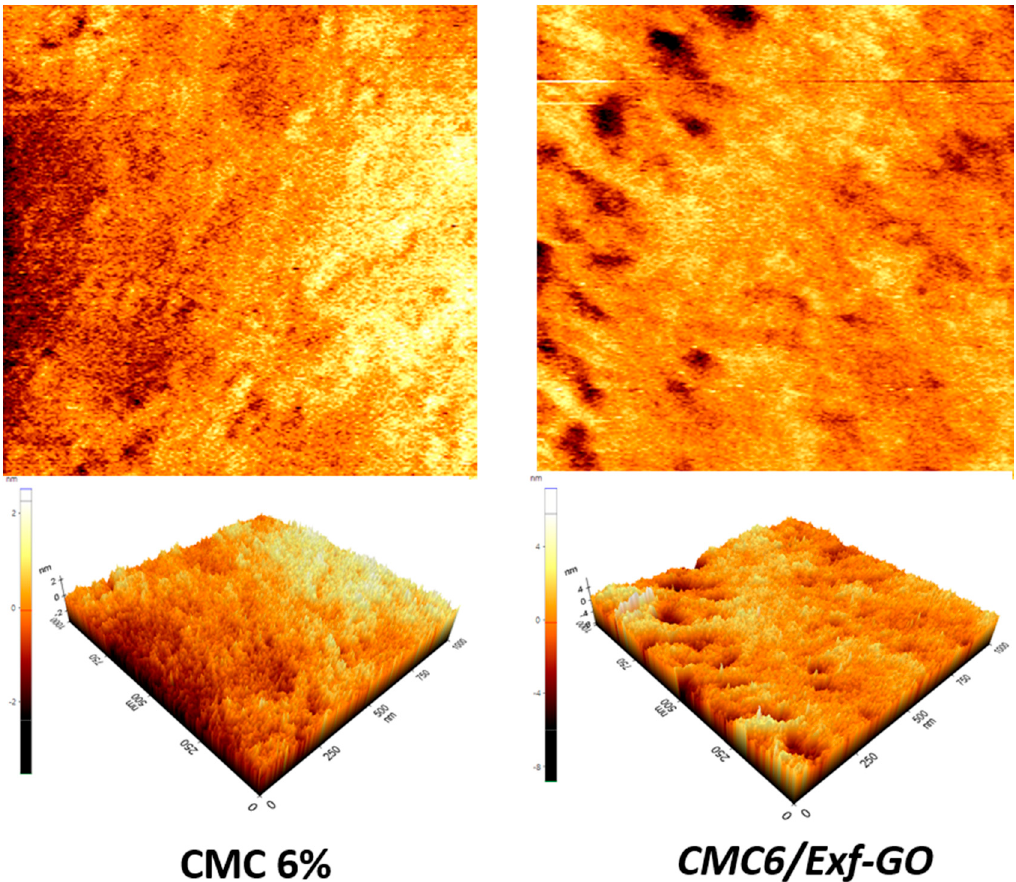
Figure 4. 2D / 3D AFM topography images for the CMC films (left side) and CMC6 / Exf -GO Figure 4. 2D/3D AFM topography images for the CMC films (left side) and CMC6/ Exf -GO nanocomposite (right side) obtained in contact mode for a scanning area of 1 µ m × 1 µ nanocomposite (right side) obtained in contact mode for a scanning area of 1 × 1 m.